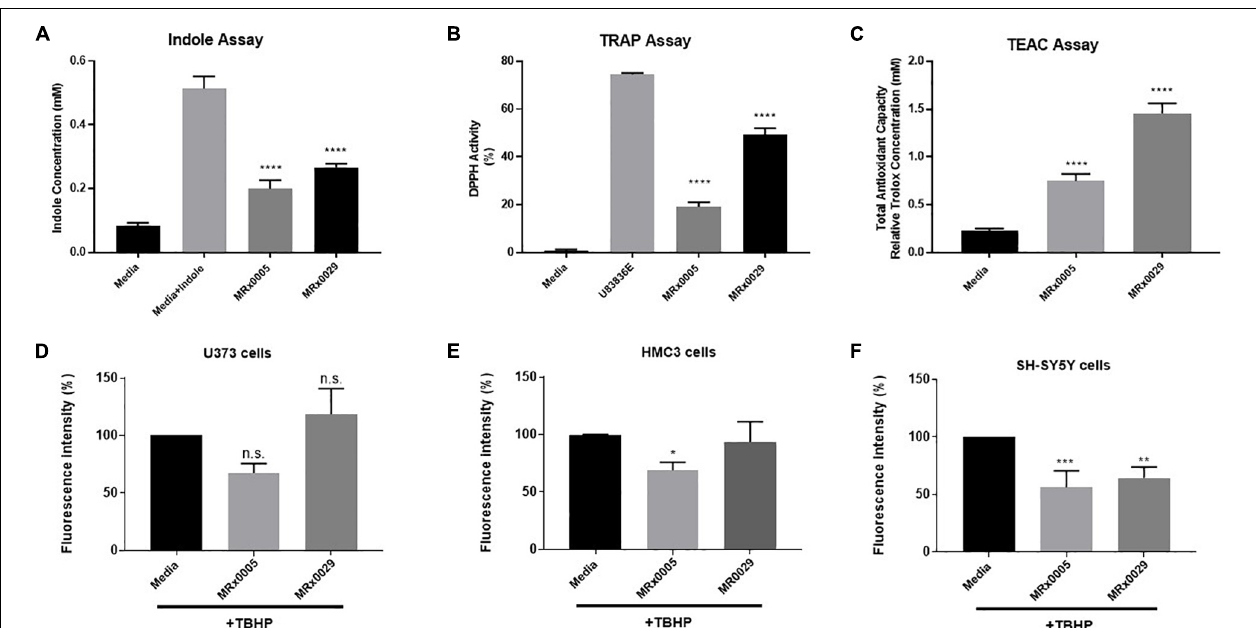
FIGURE 2 | Antioxidant capacity of MRx0005 and MRx0029: Implication for neuro-protection. MRx0005 and MRx0029 bacteria were grown to stationary phase. Biochemical assays were performed as described in section “Material and Methods.” (A) Indole concentration (mM); (B) DPPH scavenging activity assay reported as percentage related to positive control compound U83836E; (C) Total antioxidant capacity relative to Trolox concentration (mM). Each value in the graph represents the mean of three experiments corresponding to three cultures of MRx0005 and MRx0029. Data are mean ± SEM ( n = 3). (D) U373 cells, (E) HMC3 cells, and (F) differentiated SH-SY5Y cells were stained with DCFDA probe, then treated with 10% BCFS from MRx0005 and MRx0029 or media in the presence of TBHP for 2 h, followed by measurement of fluorescence intensity at Ex/Em = 485/530 nm. Data are mean ± SEM (respectively n = 4, n = 3, and n =